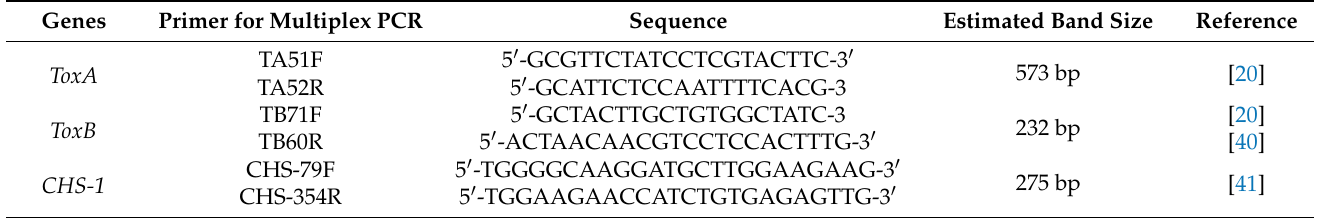
Table 1. The sequences of the oligonucleotide primers used for multiplex PCR for amplification of ToxA and ToxB genes in Pyrenophora tritici-repentis